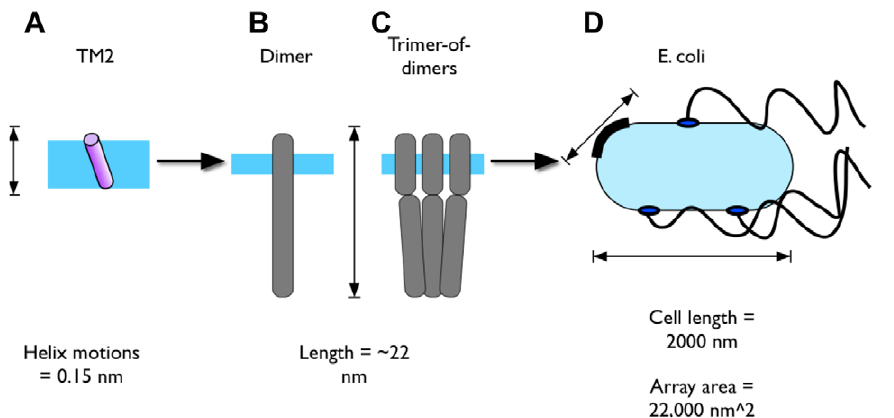
Figure 1. Schematic diagram of Tsr and chemosensing in E.coli . Scales in bacterial chemotaxis: A motions of a single helix in Tsr over , 0.15 nm cause changes in the 22 nm scale structures of the receptor dimer B and trimer-of-dimers C. This in turn induces conformational changes in a hexagonal array D at the pole of the cell (with a surface area of 22000 nm 2 ) which downstream (via diffusion of effectors along the 2000 nm cell length) results in a change the direction of rotation of the flagellar motors and the movement of the cell.